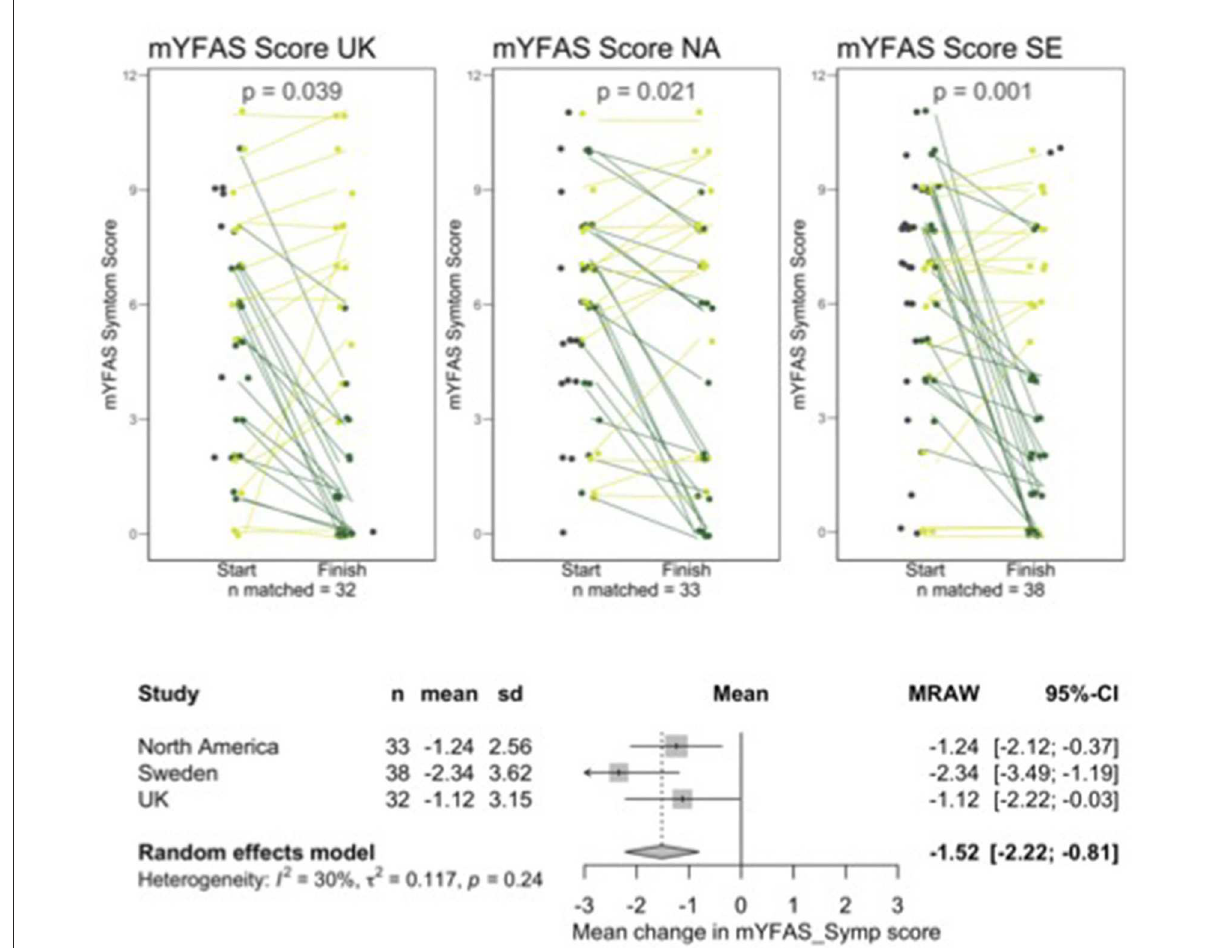
FIGURE1 Line and forest plots for mYFAS2 symptom score. Dark green indicates improved scores, light green indicates worsening score or no change. Dark gray data points without a line represent people who started but did not finish or who completed a follow up questionnaire but could not be matched with a starting